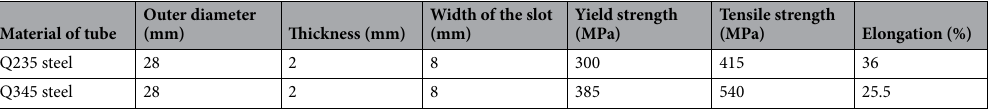
Table 2. Basic mechanical parameters of the two tubes.